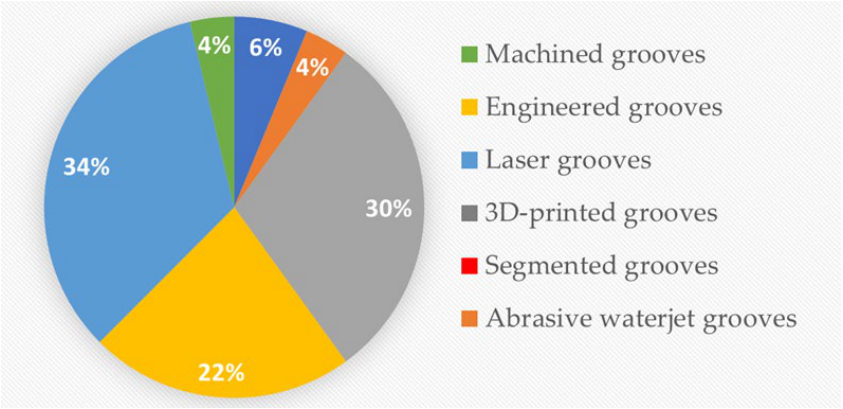
Figure 2. Distribution of works according to groove processing method.